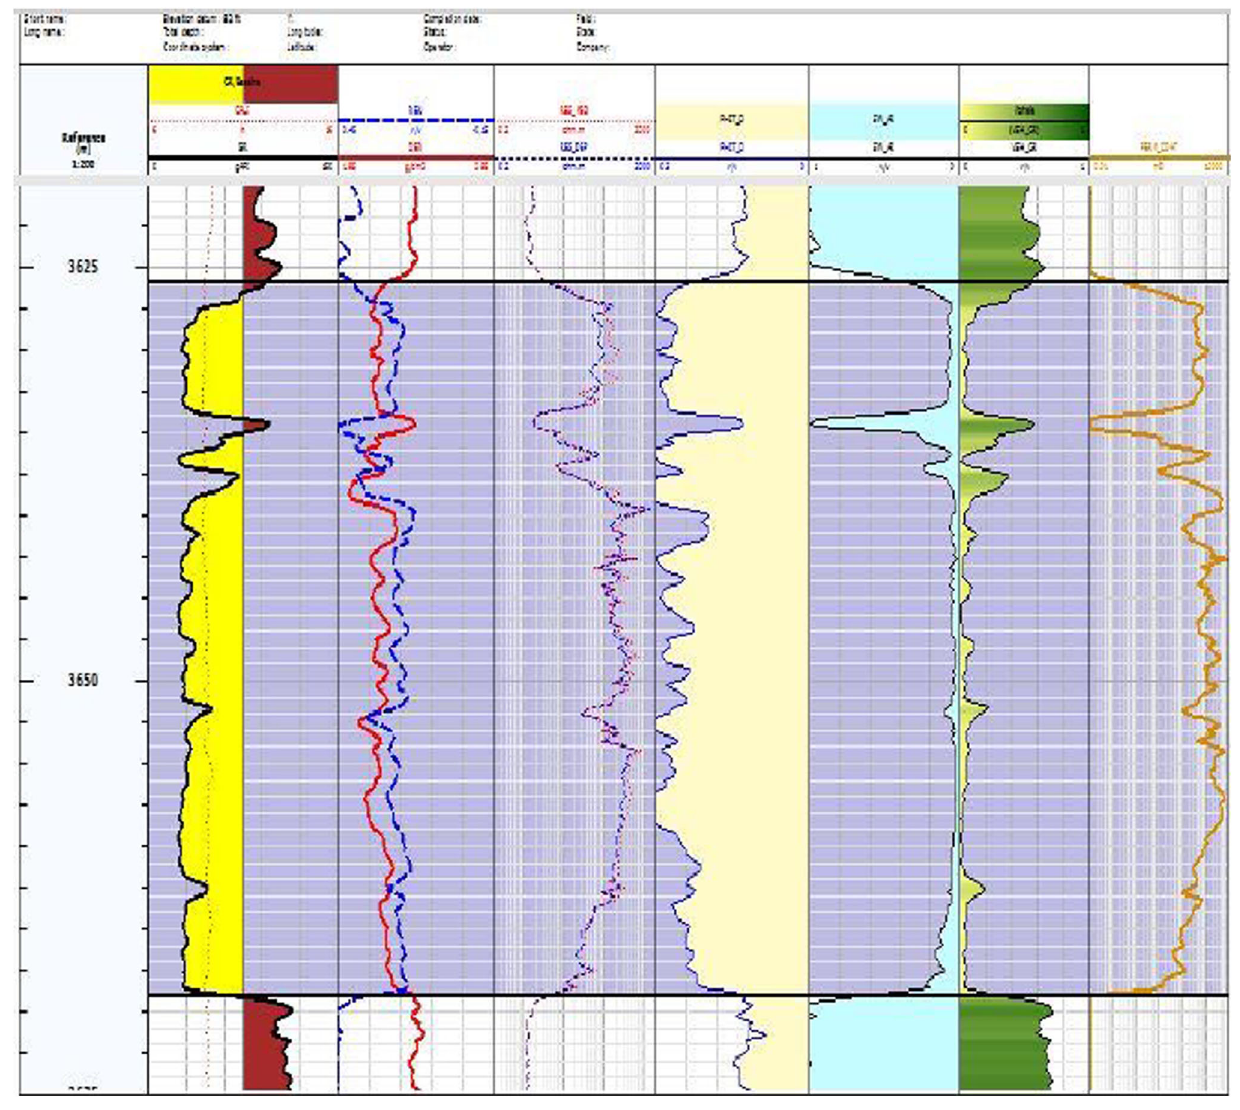
Fig. 2 Typical logs for a well in the reservoir X (Awejori